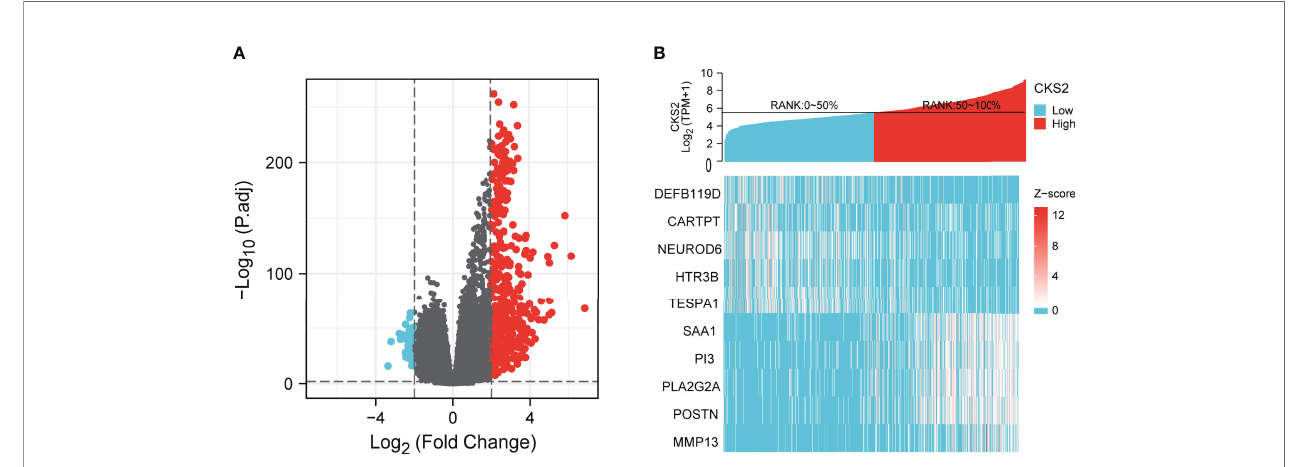
in fi ltration of 24 immune cells and CKS2 expression are shown in Figure7A . CKS2 expressionwaspositivelycorrelatedwithTh2cell ( p < 0.001, R = 0.780, Figure 7B ), helper T cell ( p < 0.001, R = 0.160, Figure7C ), activated dendritic cell ( p < 0.001, R = 0.320, Figure7D ), macrophage ( p < 0.001, R = 0.360, Figure 7E ), and neutrophil ( p < 0.001, R =0.290, Figure7F )in fi ltrationbutnegativelycorrelatedwith mast cell ( p = 0.001, R = − 0.110, Figure 7G ) and CD8 + T cell in fi ltration ( p < 0.001, R = − 0.140, Figure 7H ). ssGSEA analysis also demonstrated that CKS2 mRNA expression was not associated with thein fi ltrationofTh1( p =0.277, R =0.042, Figure7I )andBcells( p = 0.117, R = − 0.060, Figure 7J